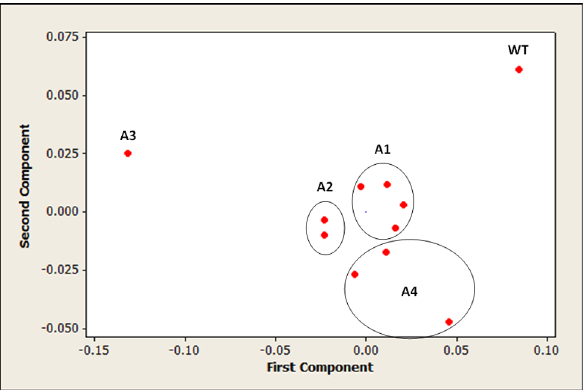
Figure 3. Levels of Cellulose rich and hemicellulose rich fractions in stem tissue of wild type and rab A knockout lines. The residue from the pectin extraction was fractionated using KOH into (A) The cellulose rich fraction and (B) The hemicellulose rich fraction. Each fraction was dried and weighed. The statistical values are as follows; ‘‘cellulose rich’’ fraction p , 0.001 (d.f,32 v.r,6.8); ‘‘hemicellulose rich’’ fraction p , 0.001 (d.f,32 v.r,15.04) with letters annotating significant difference between means.